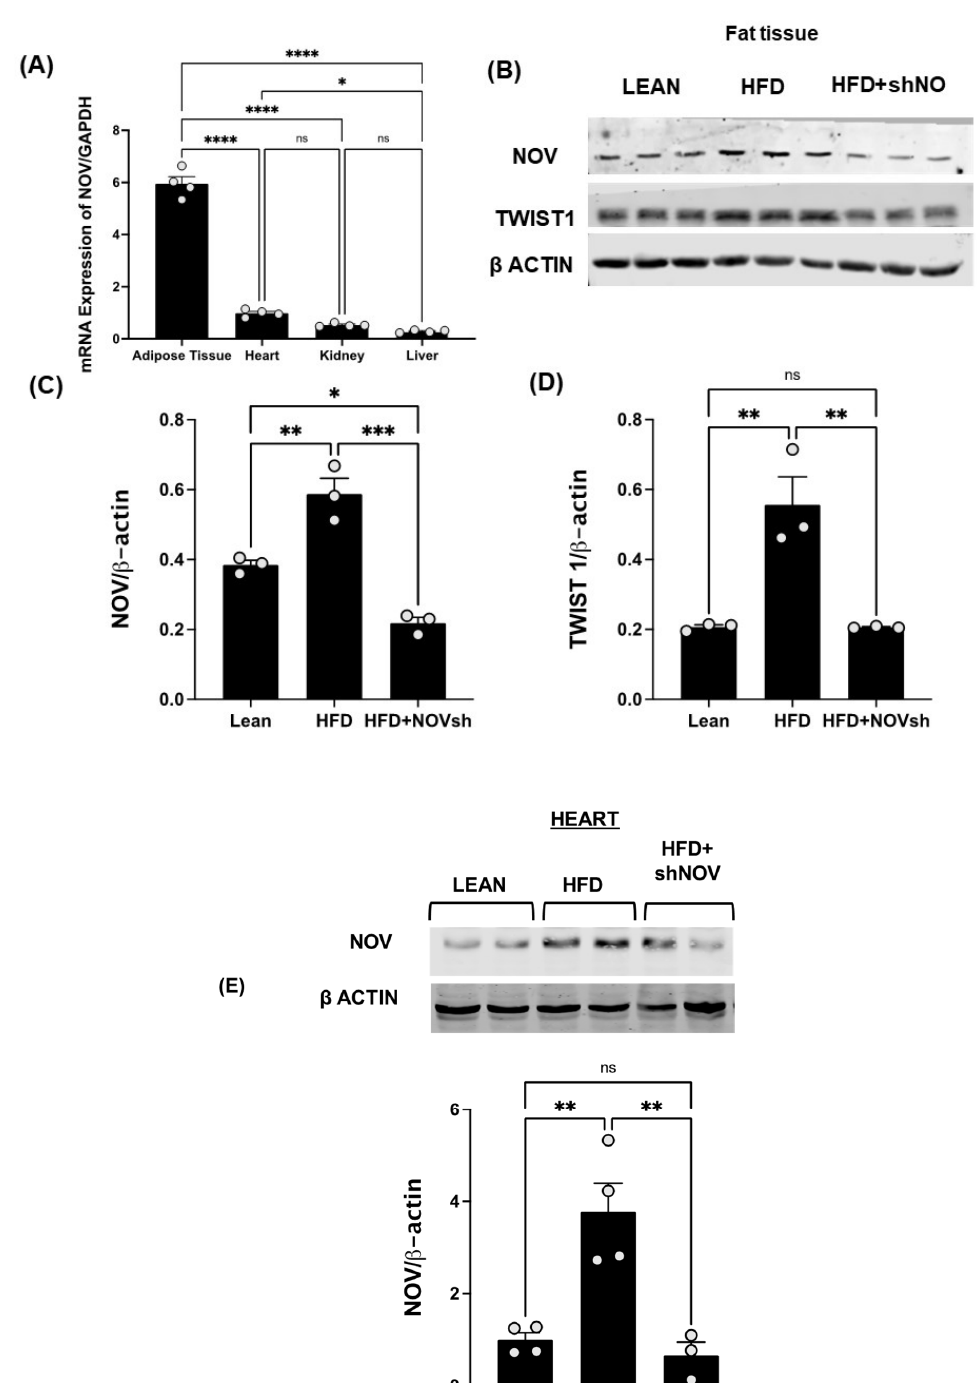
Figure 4. In vivo activation of NOV in the adipose tissue of mice fed an HFD: effects of NOV knockdown (shNOV) treatment. mRNA levels of NOV in the adipose tissue, heart, kidney, and liver ( A ), * p < 0.05 versus adipose tissue in mice on an HFD or Adipo- shNOV transgenic mice on an HFD N = 4, * p < 0.05 vs. HFD mice. Representative western blots and quantification of NOV in adipose tissue and TWIST1 in adipose tissue ( B – D ) of lean, high-fat, and shNOV mice. * p < 0.05 versus lean. Representative western blot and quantification of NOV protein levels in the hearts ( E ) of lean, HFD, and HFD+shNOV mice. Results are means ± SE; * p < 0.05, ** p < 0.01, *** p < 0.001, **** p < 0.0001, ns = not significant, n = 3.